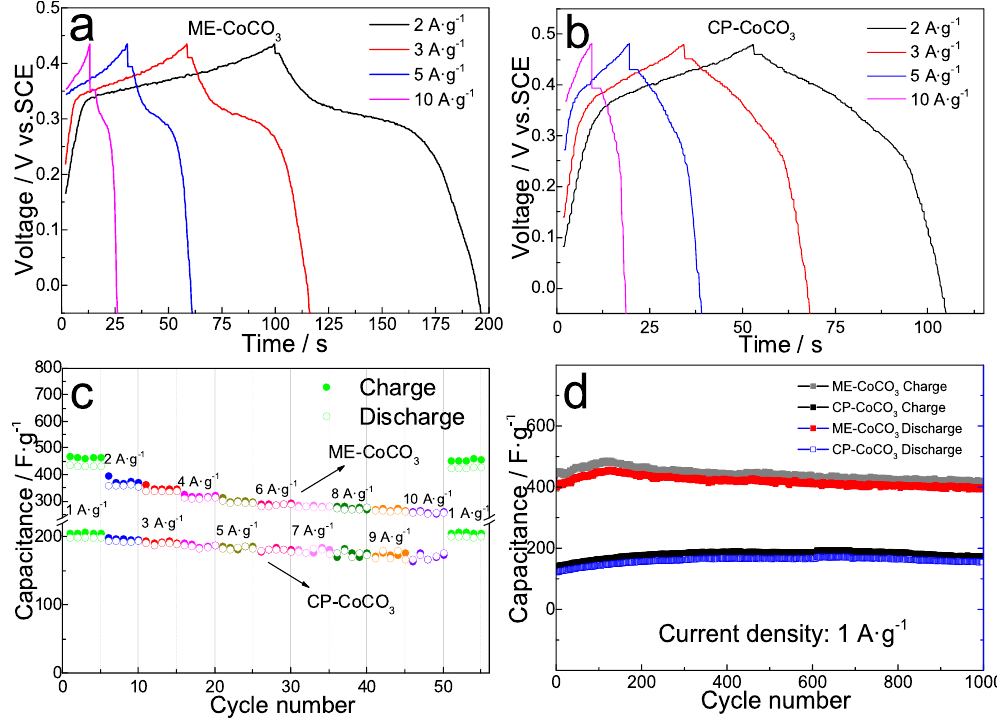
Figure 6. Galvanostatic charge-discharge curves of ( a ) ME-CoCO 3 and ( b ) CP-CoCO 3 . ( c ) Rate performances and ( d ) cycling behaviours of ME-CoCO 3 and CP-CoCO 3